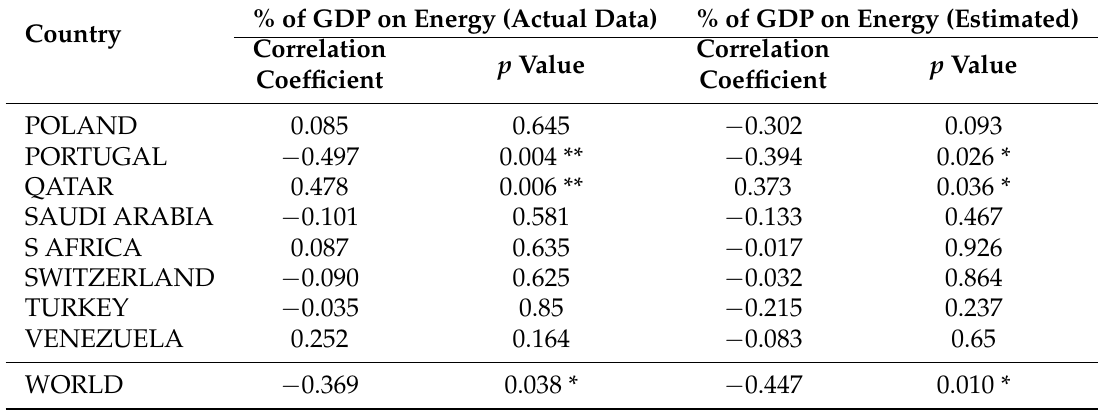
Table 2. The correlation between 1-year lagged change in total factor productivity (measured as logarithmic differences) and f e ,GDP for all energy for both the TED TFP and OECD MFP is statistically significant for several countries and the world overall. Results using Estimated f e ,GDP should